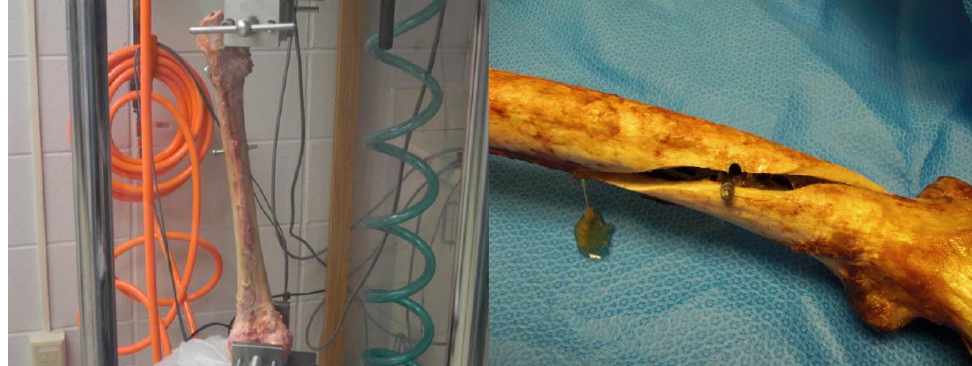
Figure 6. The femoral bone with the nail testing setup in the EnduraTEC BOSE machine ( left ). Model failure due to torsion ( right ). Reprinted from Ref. [31].